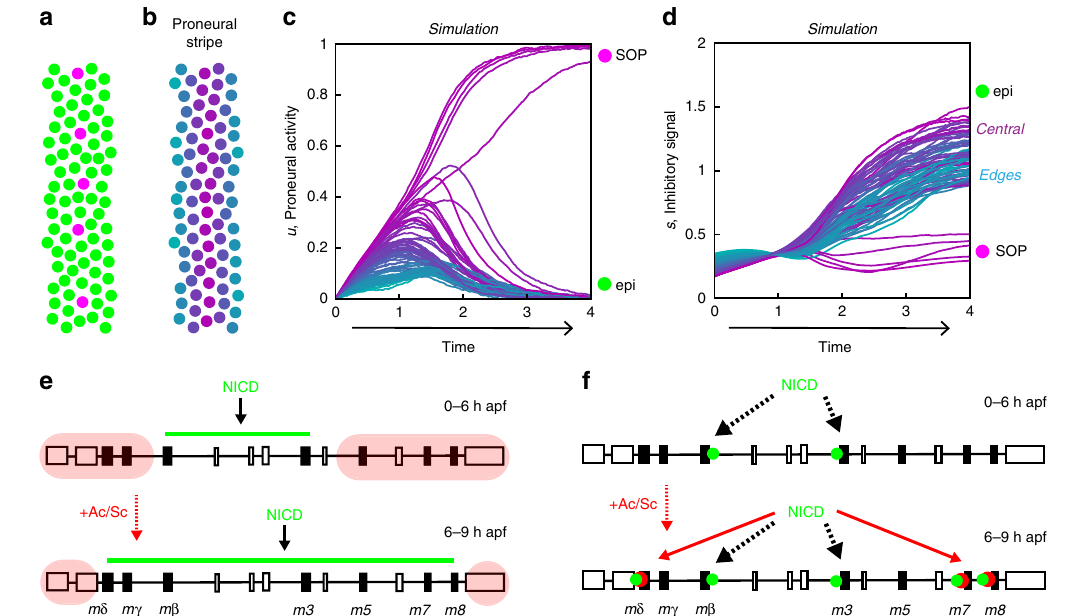
Fig. 9 Models. a – d Simulation of a mathematical model for patterning in the notum 9 . Cells within a stripe eventually reach one of two stable states, representing the SOP (magenta) or epidermal (green) cell fate ( a ). Time courses of the cell state u , representing proneural activity ( c ), and of the inhibitory signal s ( d ), which antagonizes u , are color coded according to their position within the stripe, as shown in b : cells at the center of the stripe appear in purple, whereas lateral cells are in blue. At the end of the simulation, fi ve SOPs (magenta) have emerged at the center of the stripe (c; see their positions in a , whereas the other cells adopt an epidermal fate (green). Note that lateral cells (blue) are excluded fi rst (low u values in c ). Also, while initial signal levels, which delimit the stripe, are highest on its sides, central cells (purple) rapidly show higher levels than their lateral counterparts ( d ). e , f Speculative models for the temporal regulation of the E(spl)-HLH genes. In the accessibility model ( e ), only the central region of the E(spl)-C is accessible for binding by CSL/ NICD complexes prior to Ac and Sc expression (top; green line at 0 – 6 h apf; non-accessible region in red); expression of Ac and Sc renders additional binding sites accessible at 6 – 9 h apf (bottom). In the cooperativity model ( f ), NICD (green dots) can only bind the cis-regulatory sequences of early-onset genes which contain high-af fi nity CSL binding sites (top), whereas the low-af fi nity CSL binding sites of the late-onset genes can only be bound by NICD upon expression of Ac and Sc (red dots) through cooperative binding